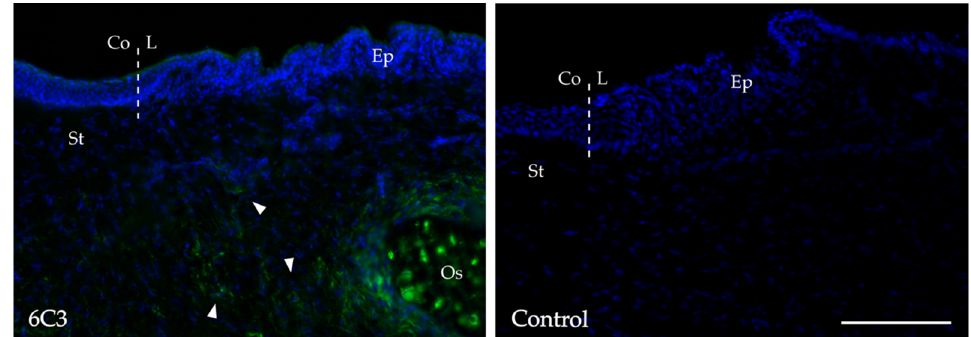
Figure 1. Immunolabelling of chondroitin sulphate (CS) proteoglycans in the adult avian limbus. Positive labelling (green) of CS specific epitopes recognised by monoclonal antibody 6C3 was ob- served in the subepithelial midstroma (white arrowheads). Nuclei counterstained with DAPI (blue). Dashed vertical white lines represent the corneolimbal junction. The primary antibody was omitted from the control section. Ep = epithelium, St = stroma, L = limbus, Co = cornea. Os = scleral ossicle. Images are representative from three individual experiments. Scale bar represents 100 µm.